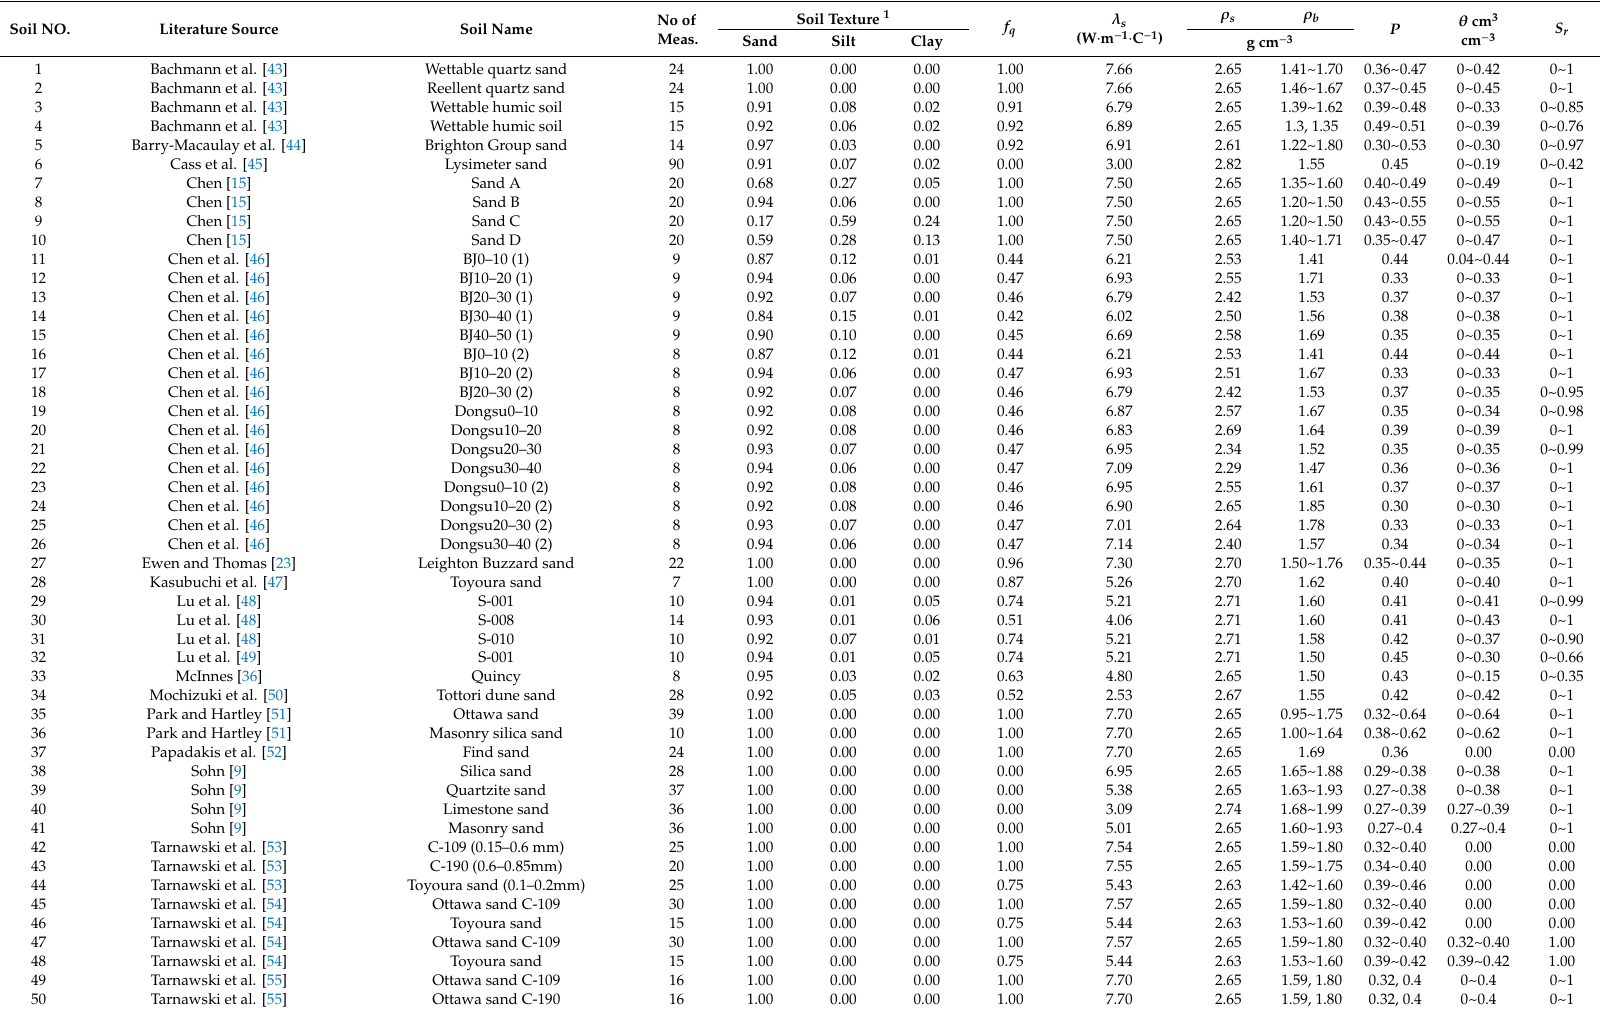
Table 1. Selected Physical Properties of Soils for Model